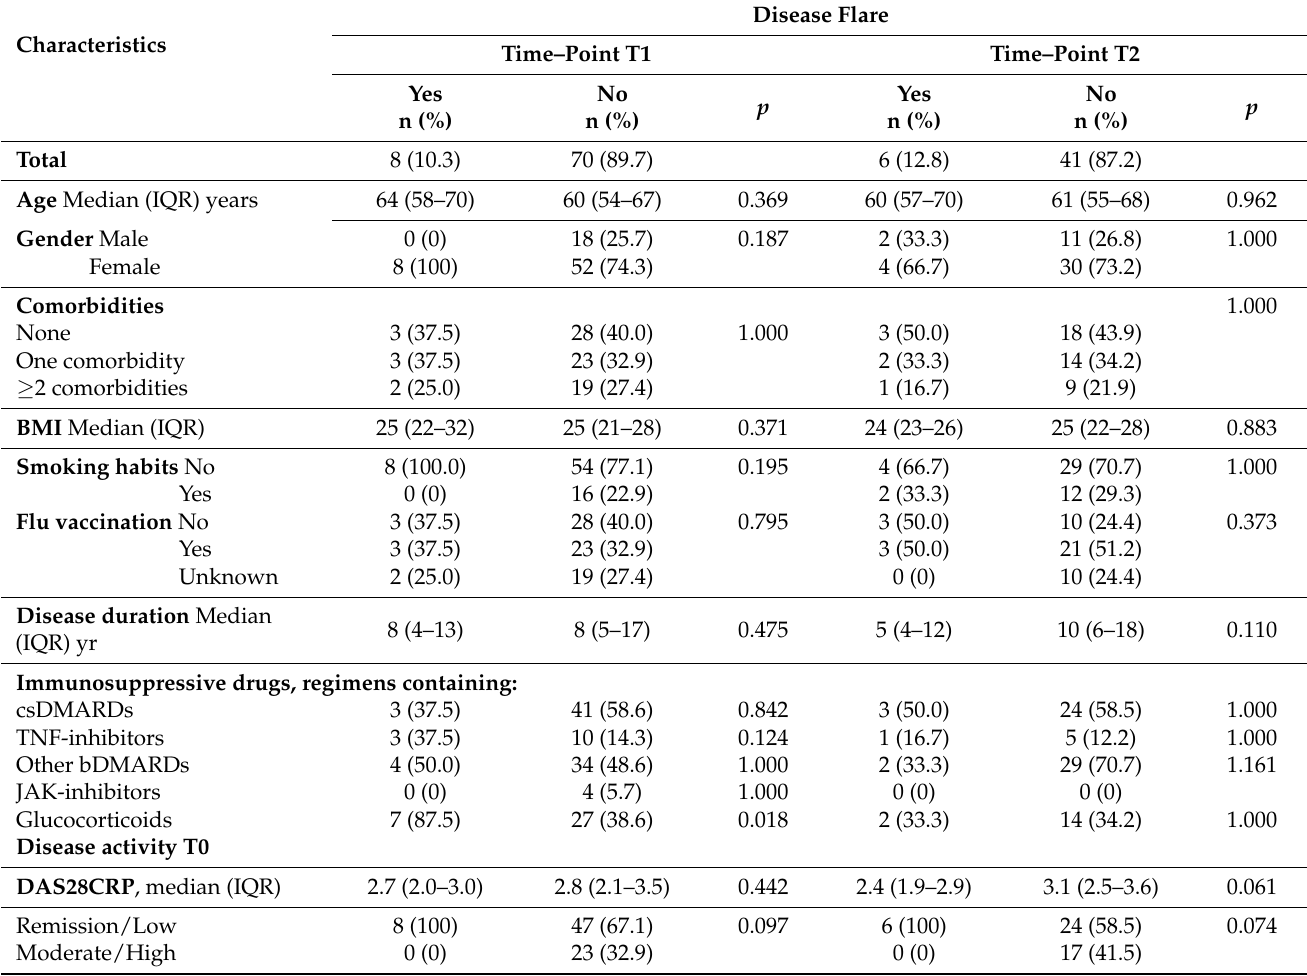
Table 3. Univariable analysis of flares according to demographic and clinical